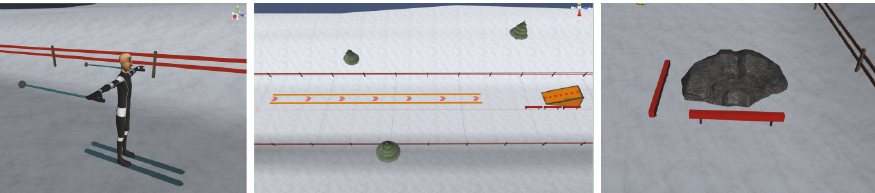
Figure 18: Slope Creep game grouped game objects saved as prefabs. From left to right: the avatar with attached ski equipment, the speed lane and ramp group, and the obstacle with attached skis (having detached from the